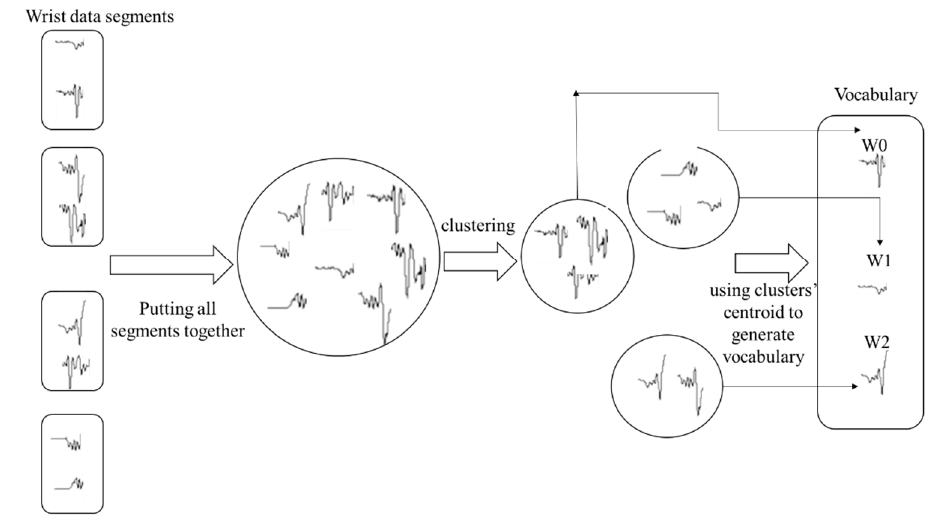
Figure 5. Epoch-based document-of-words feature engineering method—vocabulary generation phase.